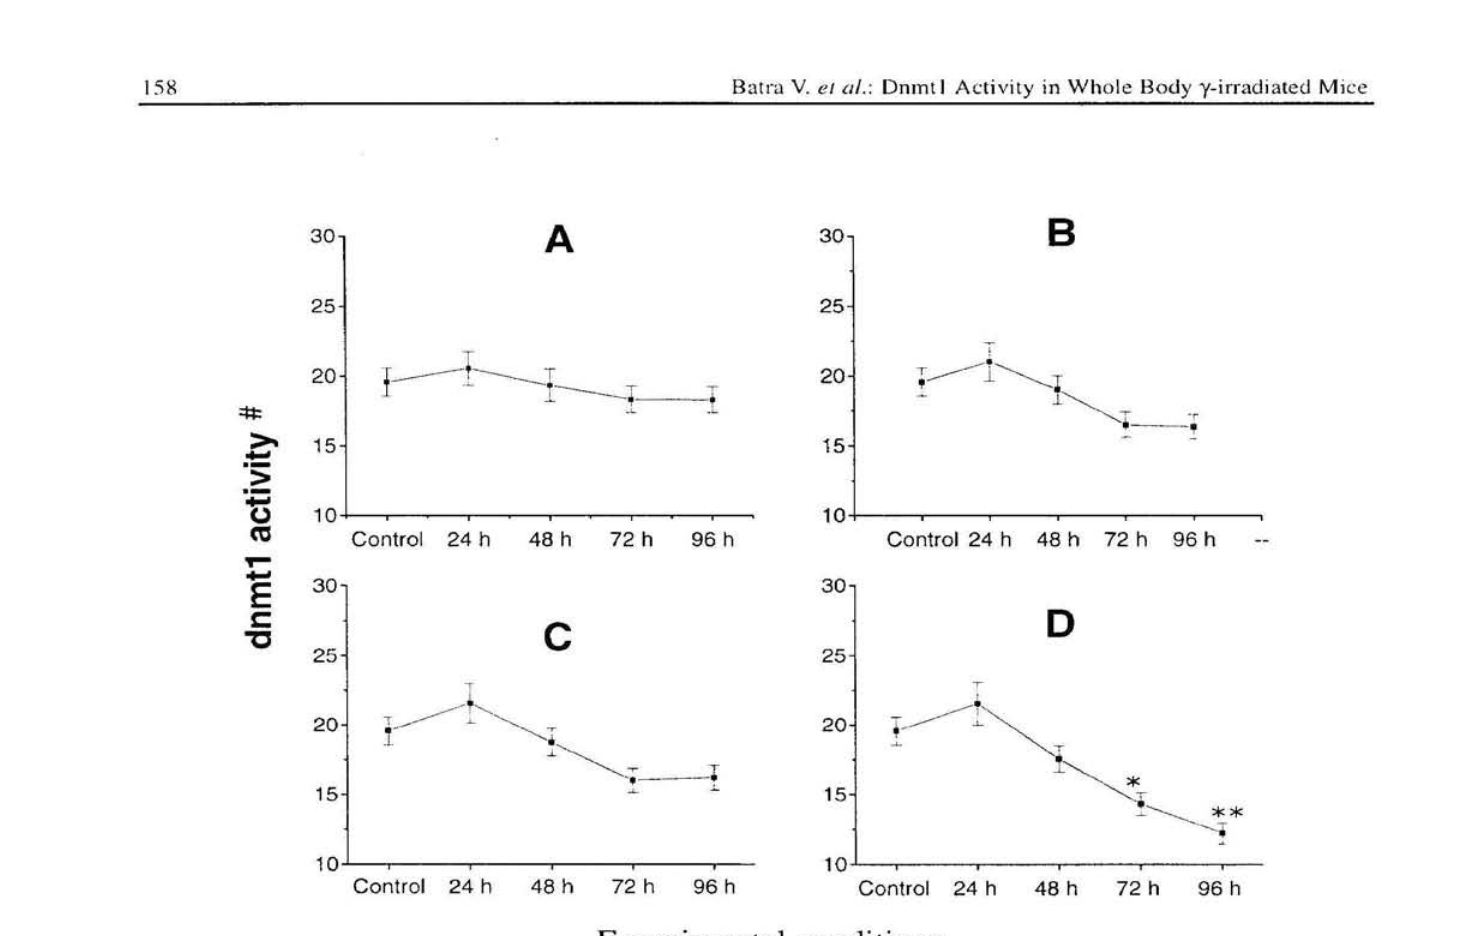
Figure 2. Modulation of supernatant dnmtl activity at various time intervals after different doses of iiTadiation. A: 1 Gy B: 3 Gy C; 5 Gy D: 7 Gy. # The activity is expressed as t'emtomole of methyl group transferred /mg pro- tein/ hour and the values are mcan ± Standard error of samples (in triplicate) from 4 animals in each group. (*P< 0.05, **P<